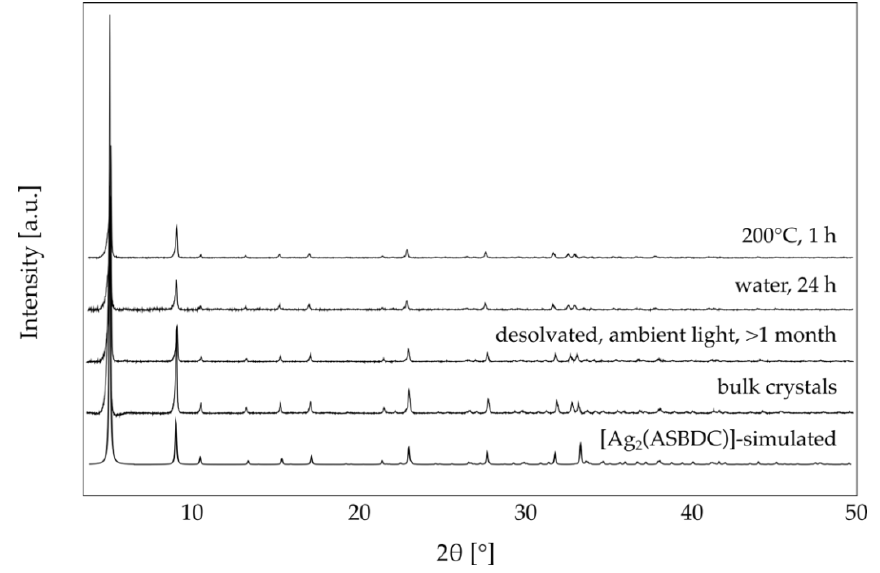
Figure 3. Powder X-ray diffraction data (Cu K α , λ = 1.5418 Å) for (Ag 2 (ASBDC)); simulated patterned from crystal structure; bulk crystalline material generated by slow MeOH evaporation; desolvated for > 1 month in air and ambient light; soaked in deionized water for 24 h; heated at 200 ◦ C in air for 1 h. See Figure S1 for additional PXRD data demonstrating the stability of (Ag 2 (ASBDC)). Materials Studio was used to calculate a surface area for (Ag 2 (ASBDC)) of ca. 149 m 2 /g, based on the single crystal density (void fraction ca. 13%; pore volume ca. 0.065 cm 3 /g using a 1.84 Å radii